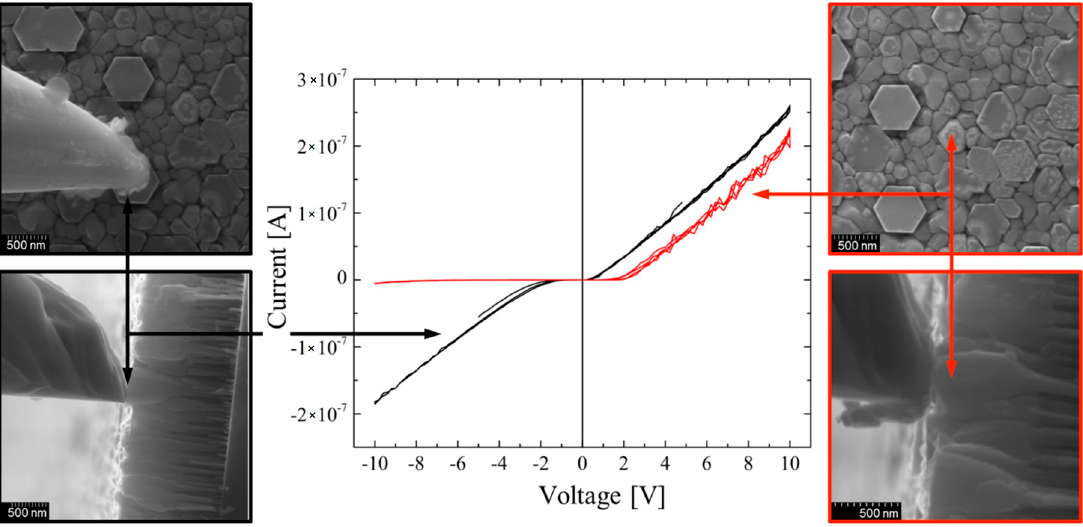
Figure 10. Series of I–V curves (central panel) of individual nanowires (NWs) (black curves: hexagonal top NWs; red curves: irregular NWs) and corresponding SEM images, showing the geometry of the measurements (sides). The sharp hexagons (black curves) exhibit nonlinear, symmetrical I–V curves with a low turn-on voltage, while the NWs with rounded edges (red curves) exhibit nonlinear and nonsymmetrical diode-like I–V curves.